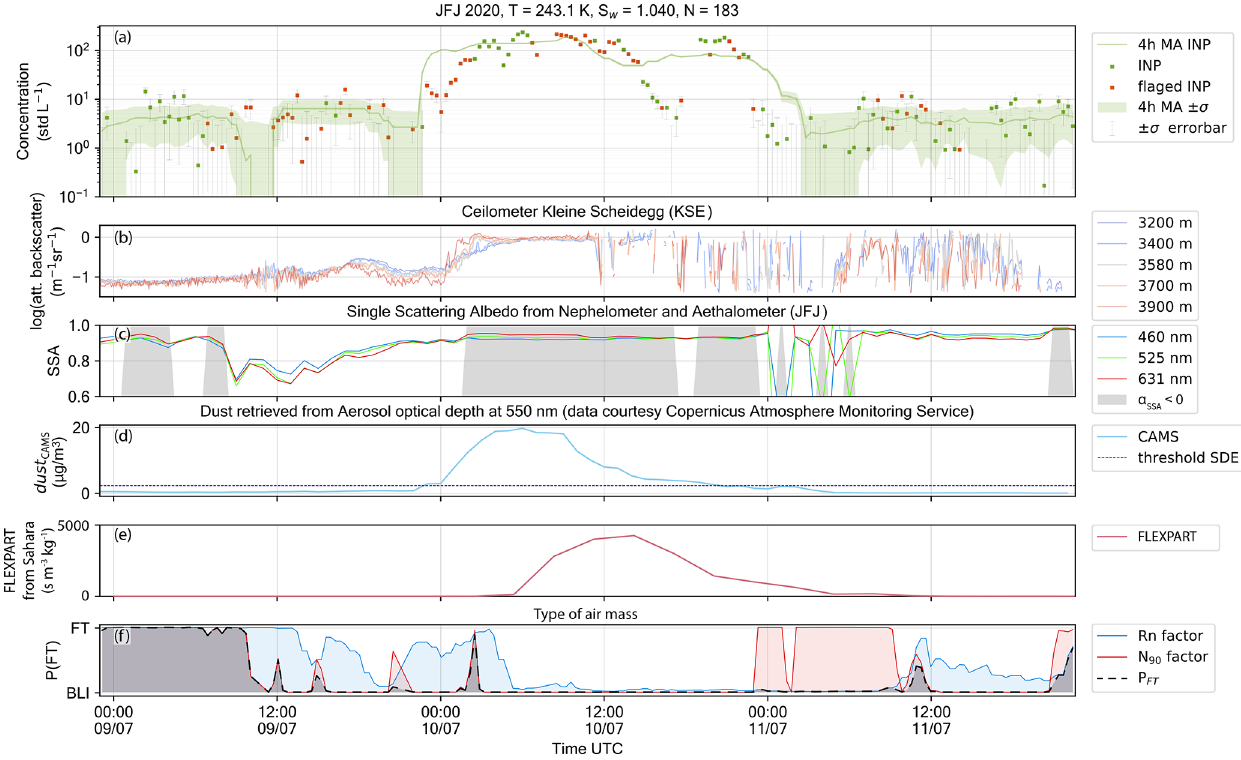
Figure 4. An example period classified as hcSDE between 7 and 11 July 2020: ( a ) measured INP concentrations with HINC-Auto at T = 243 . 15K and S w = 1 . 04 at JFJ. The error bars correspond to ± 1 standard deviation, and a 4h moving average (4h MA) is shaded in green. ( b ) The attenuated backscatter signal from the ceilometer at KSE, evaluated at different altitudes. ( c ) The single-scattering albedo (SSA) and periods for which the single-scattering albedo Ångström exponent is negative ( α SSA < 0). ( d ) Dust retrieved from satellite remote sensing generated using Copernicus Atmosphere Monitoring Service information (2020). ( e ) Cumulative surface residence time over the Sahara of particles arriving at JFJ. ( f ) The probability for free tropospheric (FT) or boundary layer intruded (BLI) air mass to be sampled at JFJ for the left-hand side factor of Eq. (1), dependant on the 222 Rn concentrations ( 222 Rn, blue line) and the right-hand side factor, dependant on the particle concentrations with a mobility diameter larger than 90nm (N 90 , red line) as well as their product, the probability of the sampled air to be of free tropospheric origin ( P FT , black dashed line).